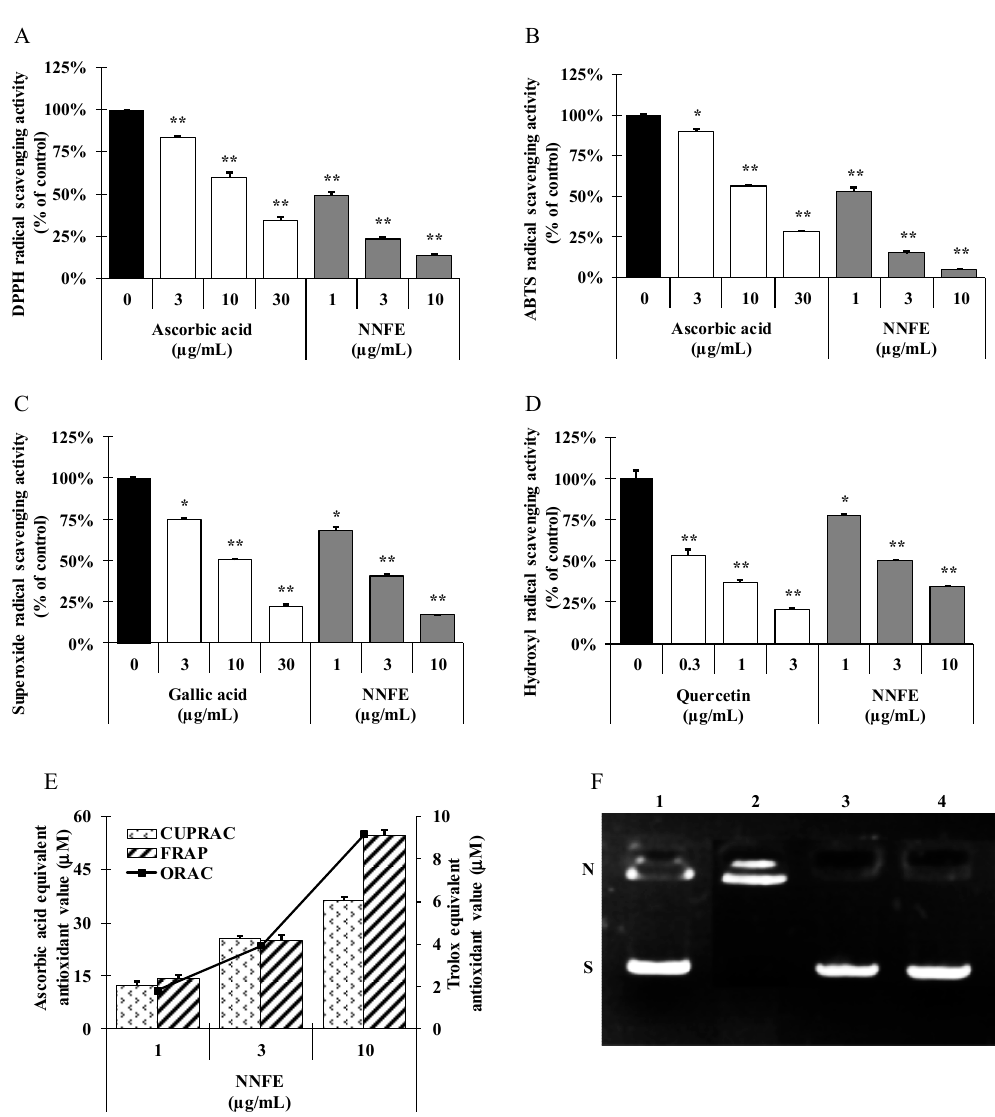
Figure 2. Radical scavenging and DNA protective effects of N. nouchali flower (ethylacetate) (NNFE) extract. 2,2-diphenyl-1-picrylhydrazyl (DPPH) radical scavenging ( A ), 2,2 ′ -azino-bis(3-ethylbenzothiazoline-6-sulphonic acid) (ABTS) • + radical scavenging ( B ), superoxide (O 2 •− ) radical scavenging ( C ), and hydroxyl (OH) radical scavenging ( D ) assays were conducted with NNFE (1, 3, and 10 µ g/mL), and ascorbic acid, gallic acid, and quercetin were tested as standard antioxidant compounds. ( E ) Cupric reducing antioxidant capacity (CUPRAC), ferric reducing antioxidant power (FRAP), and oxygen radical absorbance capacity (ORAC) assays were conducted to test the dose-dependent (1, 3, and 10 µ g/mL) effect of NNFE. Ascorbic acid equivalent antioxidant capacity was measured for the CUPRAC and FRAP assays, whereas the ORAC activities of the samples were calculated by subtracting the area under the blank curve from the area under the sample curve to obtain the net area under the curve (Net AUC). The trolox equivalent antioxidant capacity was measured as a control. Values are expressed as the mean ± SD ( n = 3). * p < 0.05 and ** p < 0.01. Statistical analysis was carried out using student’s t -test. ( F ) Agarose gel electrophoretic separation of damaged DNA and the protective effect of NNFE. 1 : DNA alone; 2 : DNA plus Cu (II)-ascorbic acid; 3 : DNA plus Cu (II)-ascorbic acid and NNFE; 4 : DNA plus Cu (II)-ascorbic acid and quercetin; S : supercoiled DNA strands; and N : nicked DNA strands. Bars: black: Negative control, white: positive control, gray: sample.